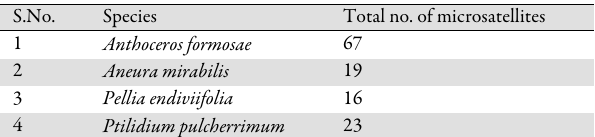
Table 3. Total number of microsatellites identified by screening chloroplast genome sequence of bryophytes (Shanker et al ., 2013a, 2013b, 2014a, 2014b)